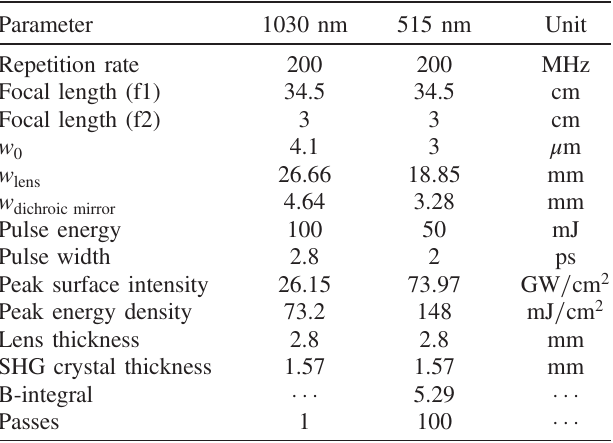
TABLE IV. ICS linear ringdown